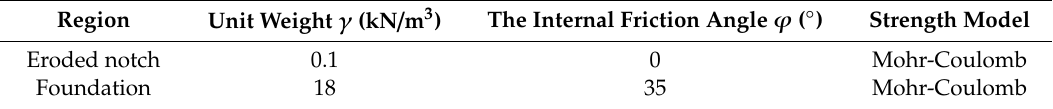
Table 3. Soil strength properties of the eroded notch and foundation used in SLOPE /